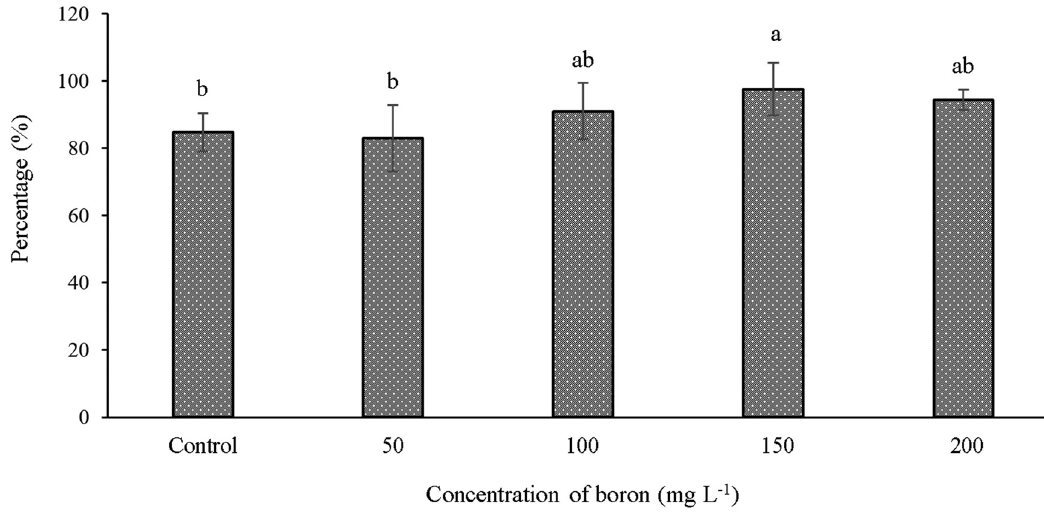
Figure 4: E ff ect of boron on dyeing pollen. Letters within the columns represent a signi fi cant di ff erence ( P < 0.05 ) .